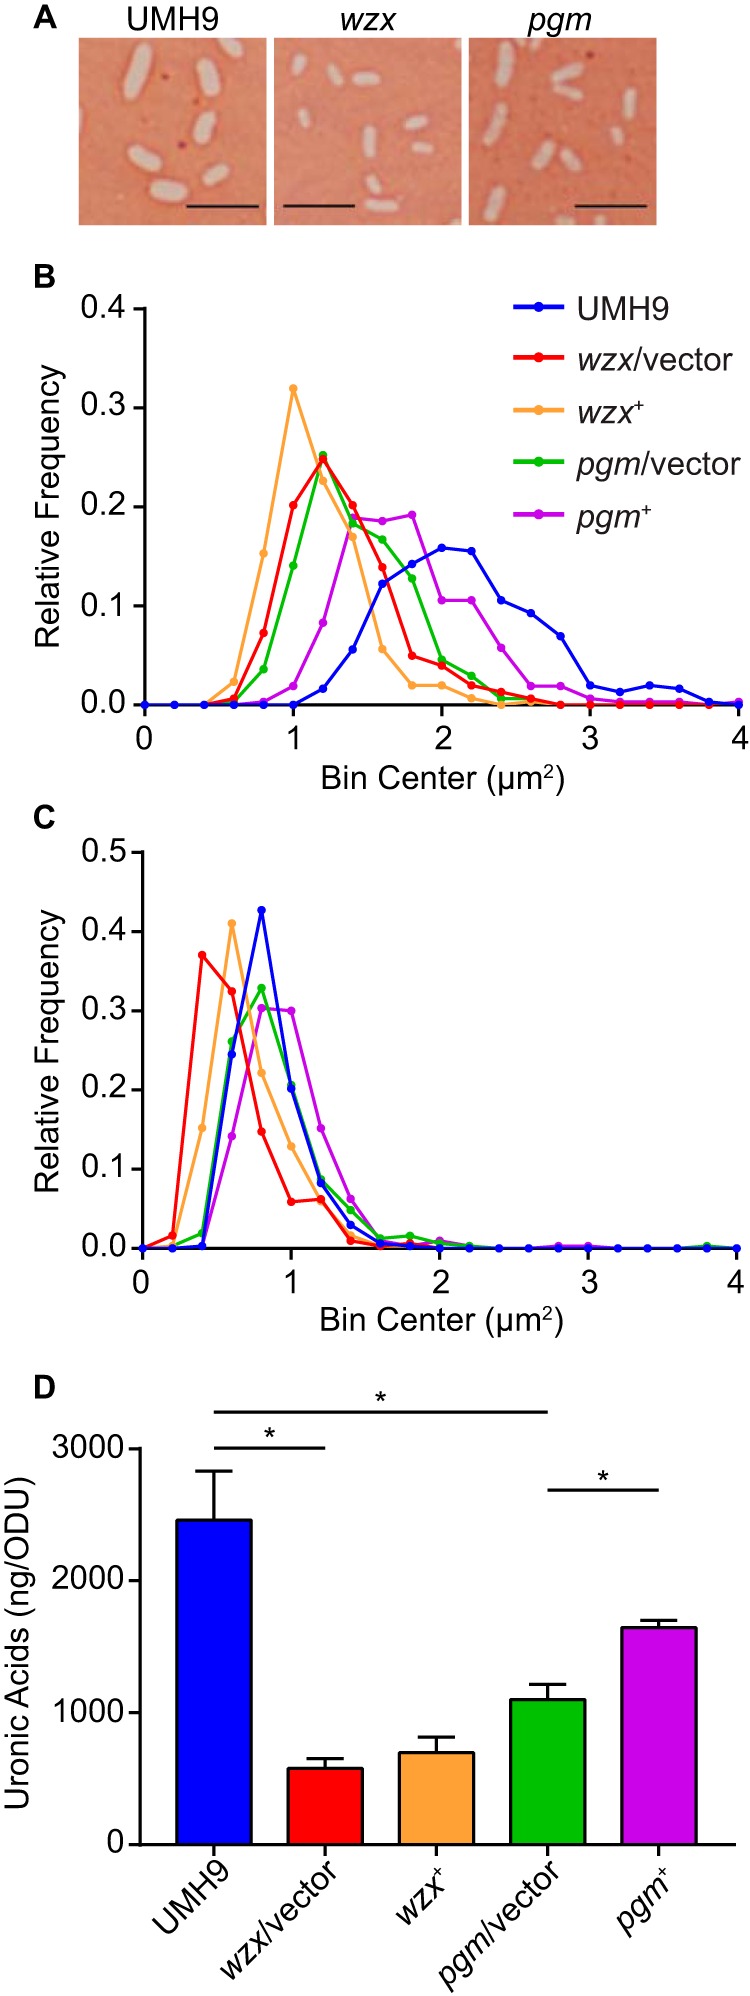
Detection of S. marcescens capsule by negative staining and measurement of uronic acids. (A) Assessment of capsule production by S. marcescens strains by CR negative staining. Scale bars, 5 µm. (B) Distribution of CR negative-stained area from individual cells of the S. marcescens strains indicated. (C) Distribution of crystal violet-stained area of individual S. marcescens cells. Colors correspond to the same strains that are indicated in panel B. Approximately 300 cells of each strain were measured for panels B and C. (D) Bacteria from overnight cultures of S. marcescens were used to measure the level of extracellular uronic acids by colorimetric assay. The amount of uronic acids present in each sample was normalized to the OD of each culture and was calculated on the basis of a standard curve generated with glucuronic acid. Asterisks indicate uronic acid levels that different significantly between strains, as determined by t test (P < 0.01, n = 3). ODU, OD unit.